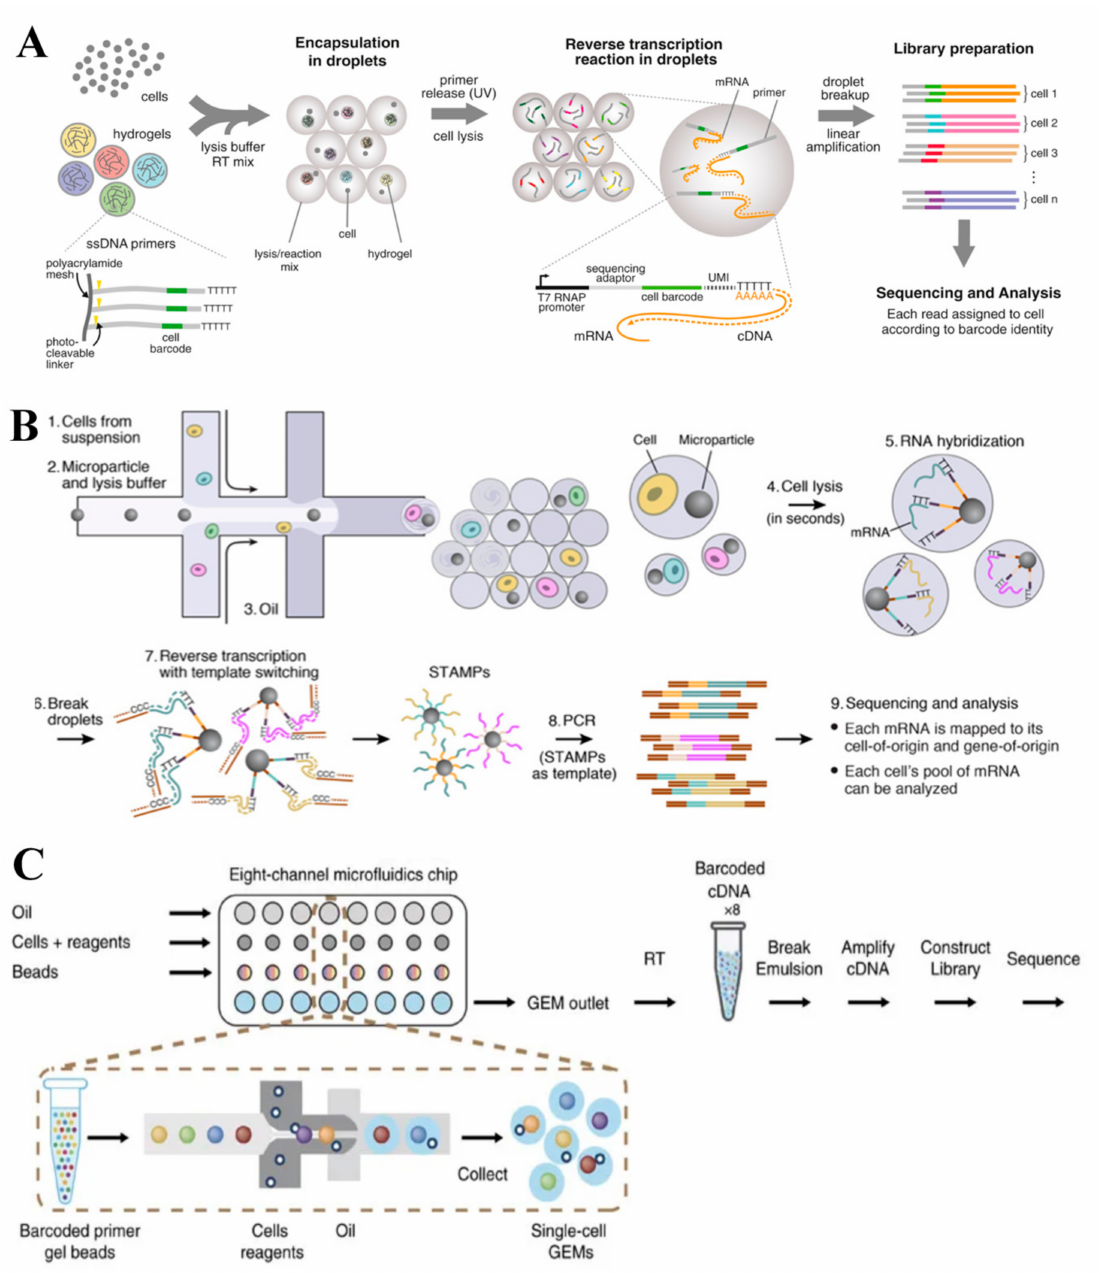
Figure 4. Droplet-based scRNA-seq technologies. ( A ) In-Drop uses hydrogel microspheres to introduce oligonucleotides and all reactions are carried out in droplets, which allows the indexing of thousands of cells for RNA-seq. Adapted with permission from Reference [24] © Elsevier (2015). ( B ) Drop-seq includes a droplet that encapsulates each single cell with a barcode, which enables fast, cost-e ff ective, and high-throughput single-cell analysis. Adapted with permission from Reference [23] © Elsevier (2015). ( C ) 10x genomics uses Gel bead in Emulsion (GEM) to introduce oligonucleotides, and both cell lysis and reverse transcription are introduced in droplets. The use of 10 × barcodes significantly increases throughput. Adapted with permission from Reference [54] © Creative Commons Attribution License